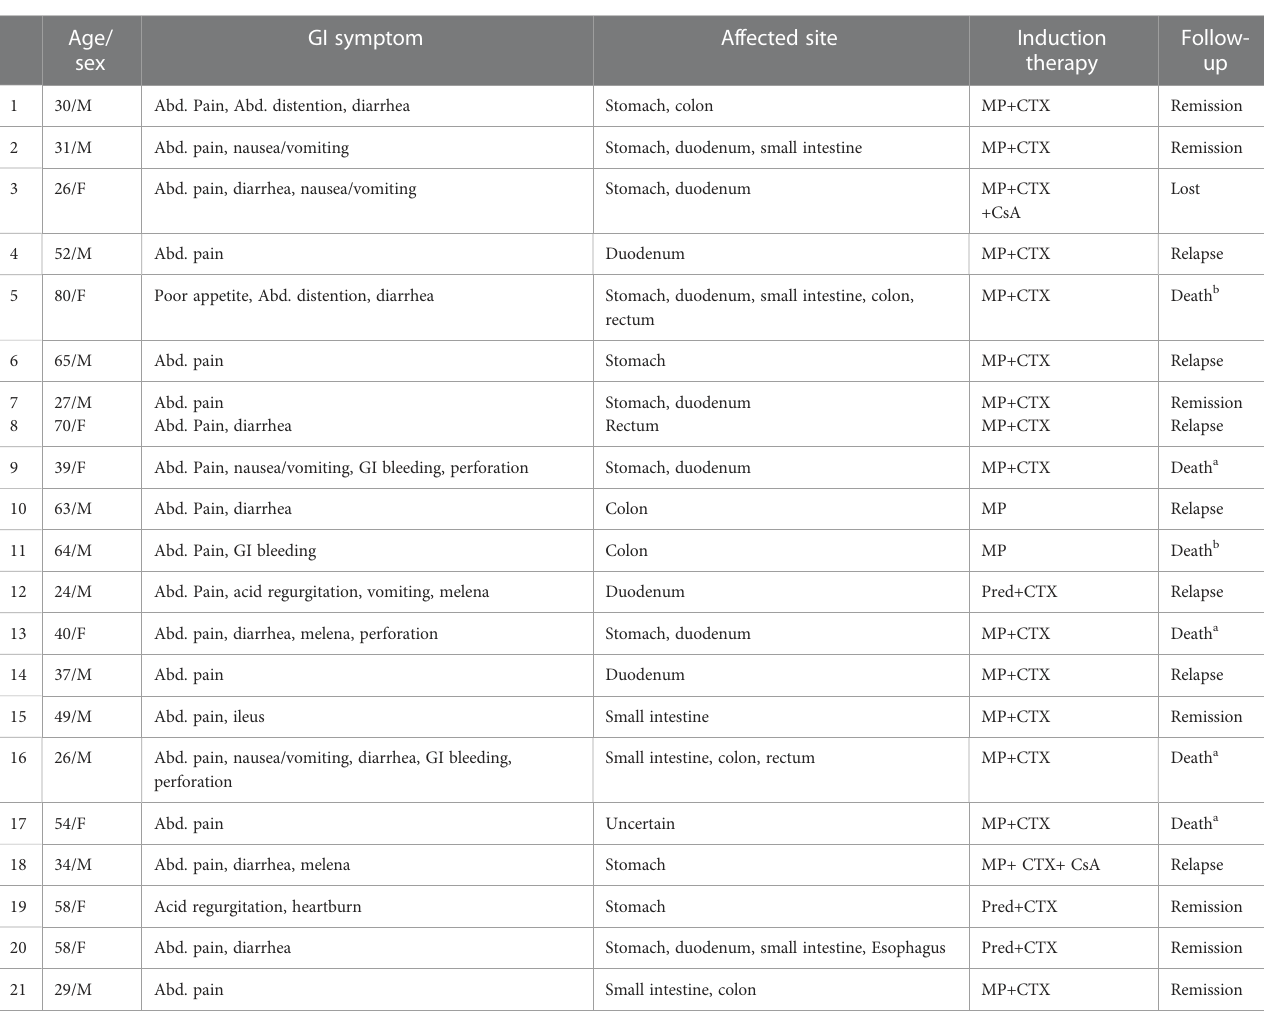
TABLE 3 Symptoms, affected site, treatment, and follow-up of EGPA patients with GI involvement. Age/ GI symptom Affected site Induction sex